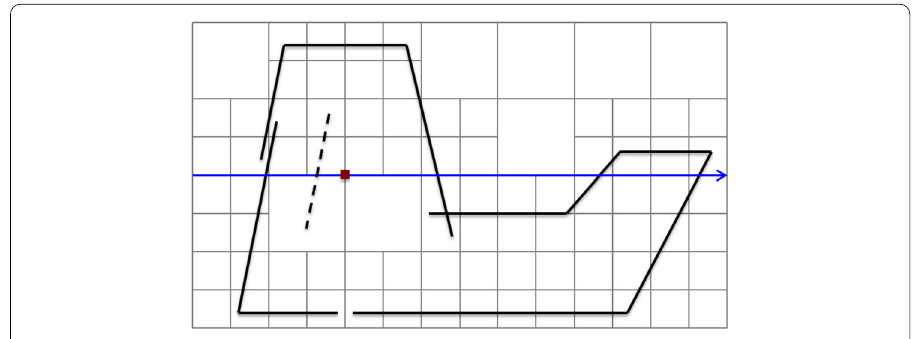
Fig. 33 Combination of closed (solid line) and double-sided structures (dashed line): double-sided structure is marked by a flag and then simply ignored in the ray casting algorithm